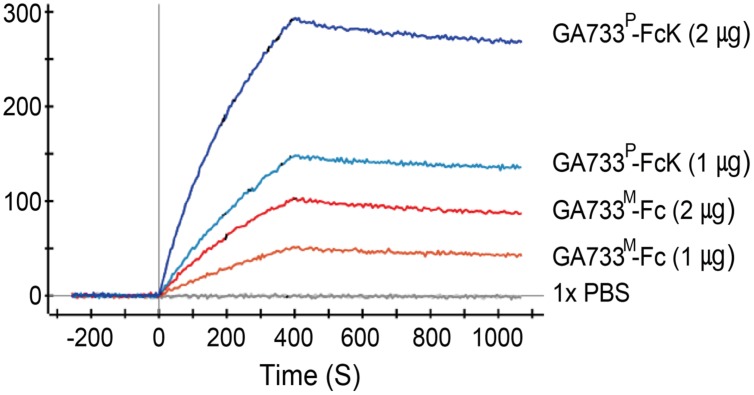
Surface plasmon resonance interaction analysis of anti-GA733 mAb binding to GA733P-FcK and GA733M-Fc. Anti-GA733 mAb was fixed on a GLC-chip. Binding of GA733P-FcK to anti-GA733 mAb (mAb CO17-1A) was analyzed using SPR.